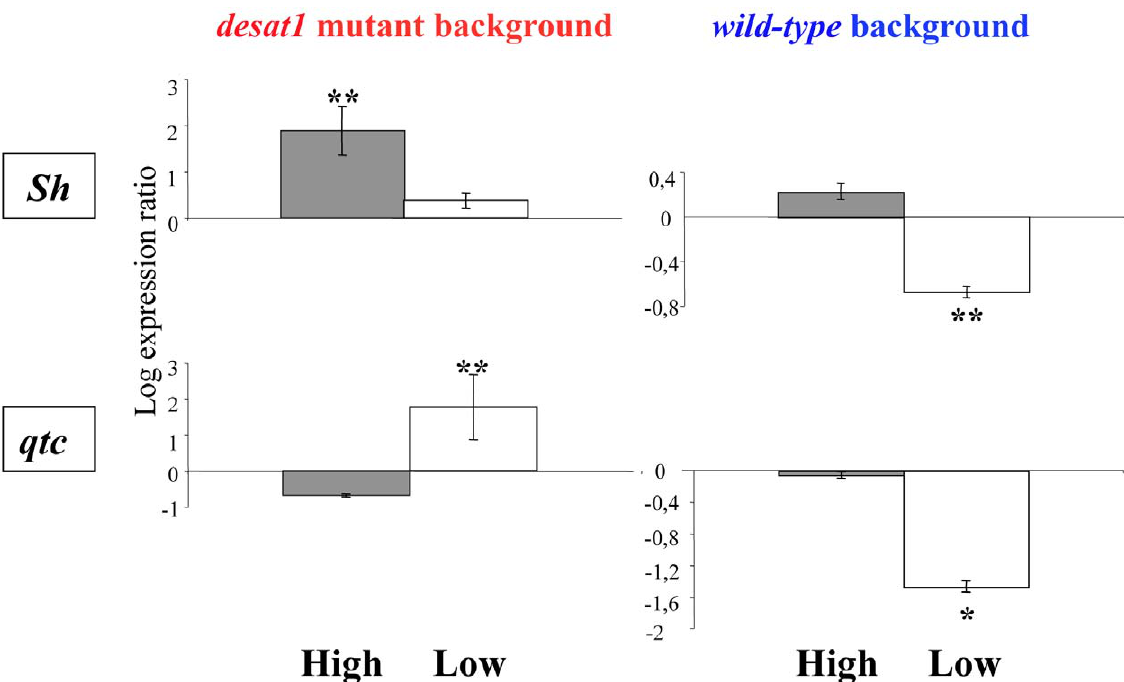
Figure 3. Gene expression activity depends both on the direction of selection and genetic background. The level of transcriptional activity was measured by q-PCR for the Shaker ( Sh , top) and quick-to-court ( qtc , bottom) genes in two genetic backgrounds: desat1 (left) and wild-type (right). Ordinate denotes to the log ratio of expression in the heads of 5-days old adult males in lines selected for high (‘‘High’’, filled bars) and low (‘‘Low’’, empty bars) sex pheromone discrimination relative to unselected lines (‘‘No’’; corresponding to ‘‘0’’). Statistics indicate the significance of the variation between selected and unselected lines. For all other information, please refer to Fig. 1.